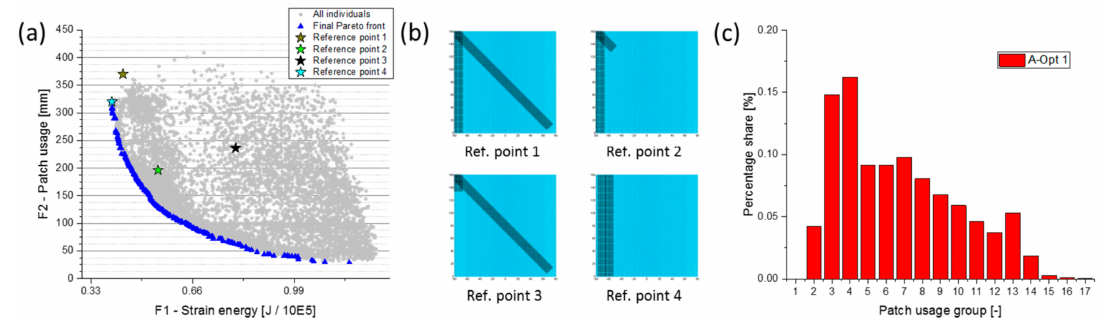
Figure 10. ( a ) Distribution of all calculated individuals in the search space of A-Opt 1 in comparison with four reference solutions. The blue points represent the final Pareto front; ( b ) Patch configurations of four reference solutions; ( c ) The red bars illustrate the resulting percentage share of all individuals (blue and grey dots in ( a )) for each patch-usage group with a step-length of 25